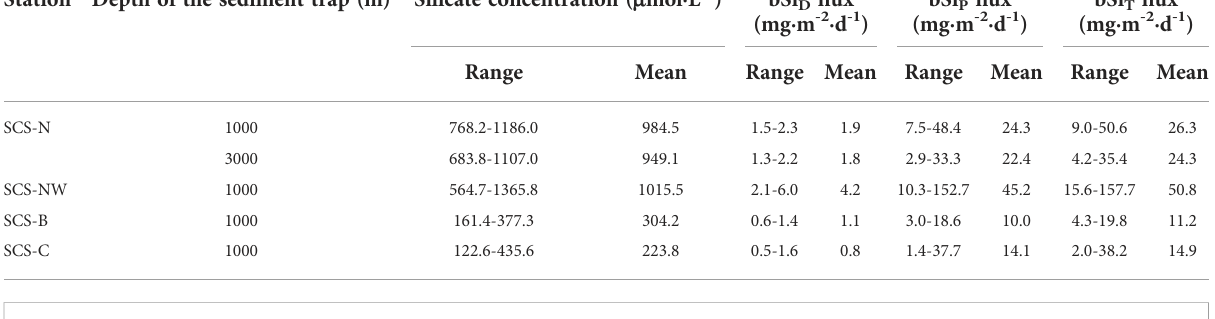
TABLE 2 Silicate concentration in the supernatant of the sampling bottles, bSi D fl ux, bSi P fl ux and bSi T fl ux at the different sediment trap stations in the SCS. Station Depth of the sediment trap (m) Silicate concentration ( m mol·L -1 )